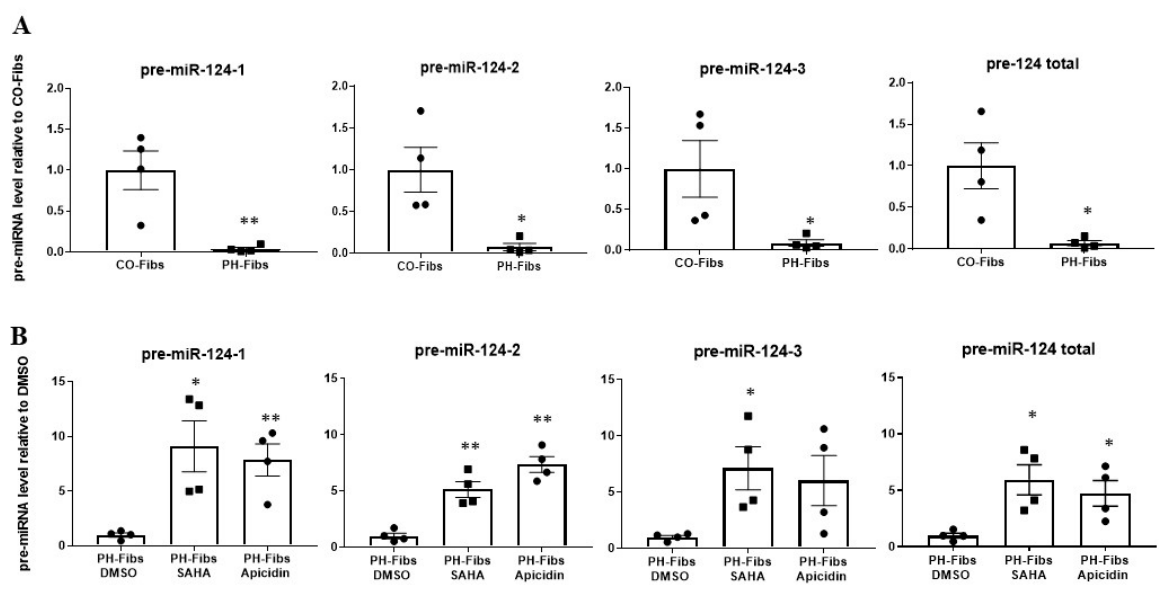
Figure 3. The levels of miR-124 precursors are significantly decreased in human PH-Fibs and can be increased by HDACi. qRT-PCR analysis of pre-miR-124-1, pre-miR-124-2, pre-miR-124-3 and total pre-miR-124 levels in human CO- ( n = 4) and PH-Fibs ( n = 4) ( A ) and in PH-Fibs ( n = 4) treated with DMSO (control) or HDACi (SAHA and Apicidin) for 48 h ( B ). Data are presented as mean ± S.E.M, * p < 0.05, ** p < 0.01 PH-Fibs vs. CO-Fibs or PH-Fibs treated with HDACi vs. DMSO.